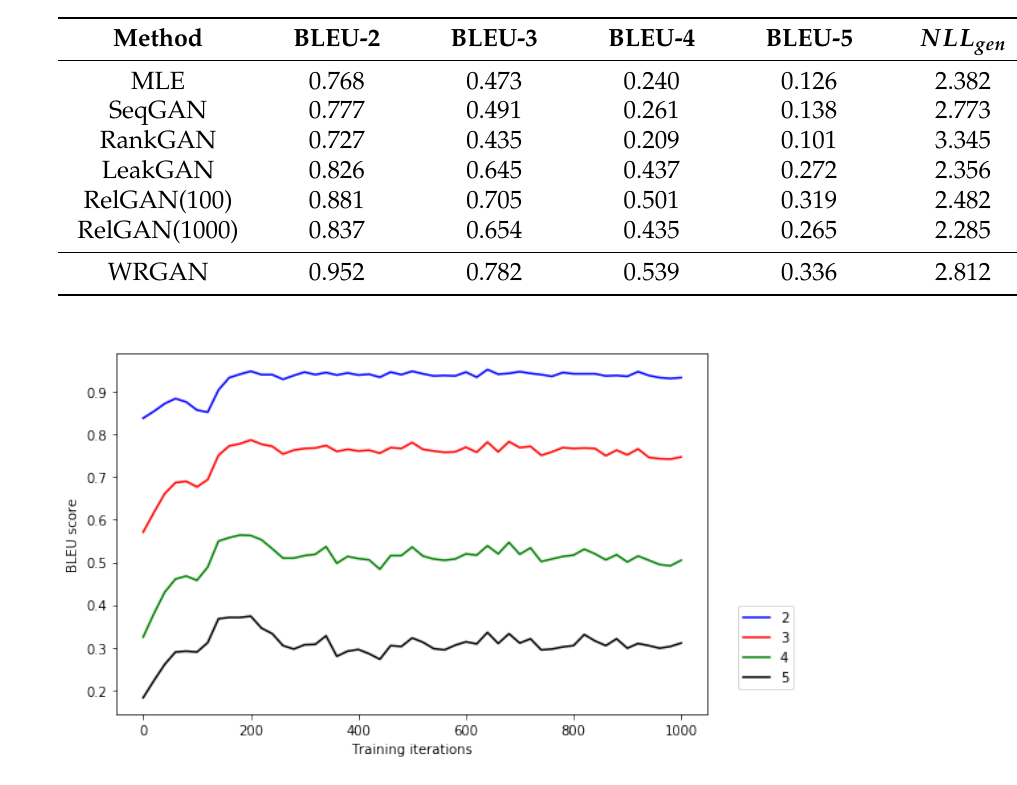
Figure 7. The BLEU scores for EMNLP2017 WMT News with Dimension = 256.